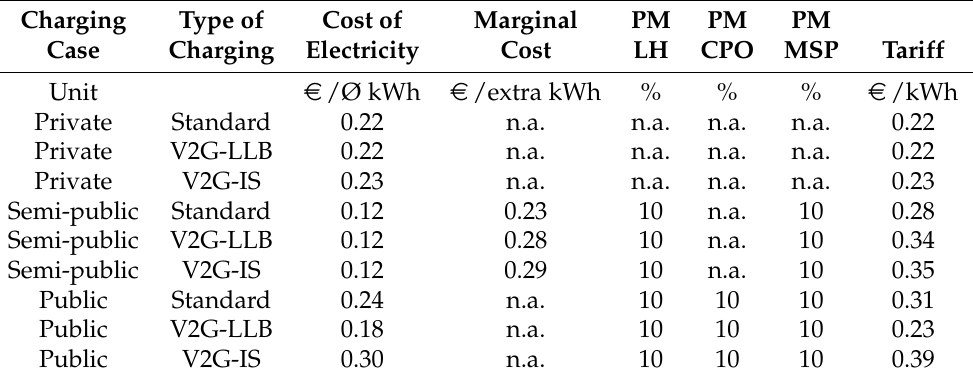
Table 5. Tariffs for different charging cases (PM = profit margin, LH = location holder, CPO = charge point Operator and MSP = mobility service provider, source: own compilation).